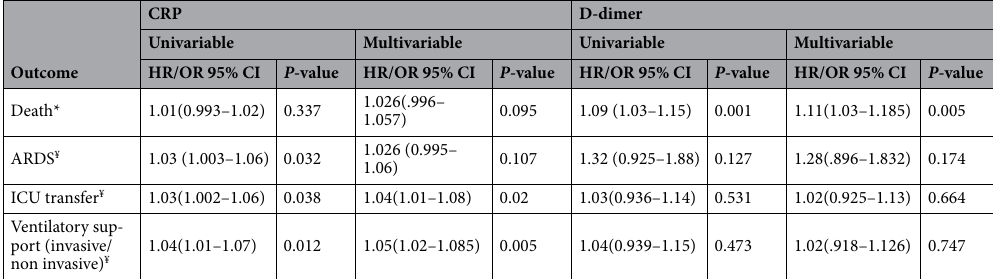
Table 3. Unadjusted and multi-adjusted associations of 1 SD increase of C-reactive protein and DD with the main study outcomes. *Results obtained from Cox regression. ¥ results obtained from logistic regression. Adjusted associations are controlled for the effect of age, gender, cardiovascular disease and admission creatinine.